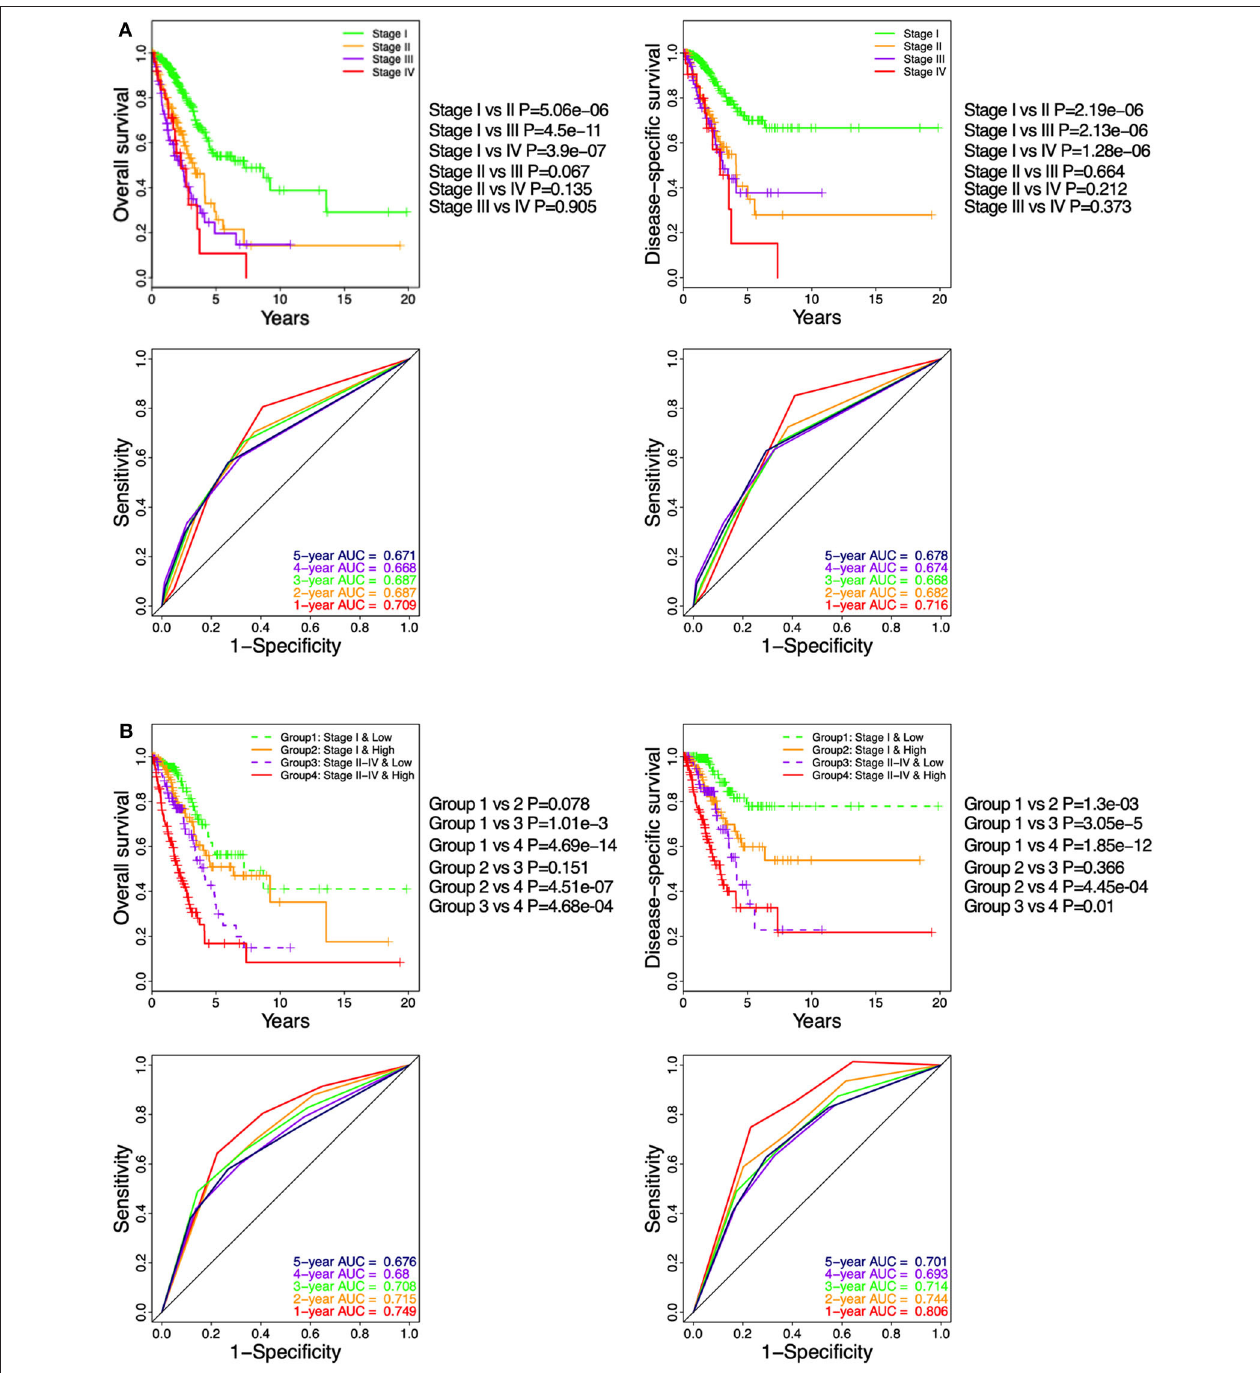
FIGURE 6 | Stratification analysis on The Cancer Genome Atlas (TCGA) cohort based on immune-cell characteristic score (ICCS) and pathologic stage. (A) Kaplan–Meier analysis and time-dependent receiver operating characteristic (ROC) curves show the prognostic values of the pathologic stage using the TCGA cohort. (B) Kaplan–Meier analysis and time-dependent ROC curves present the prognostic values for patients grouped by combining the stage and the ICCS.